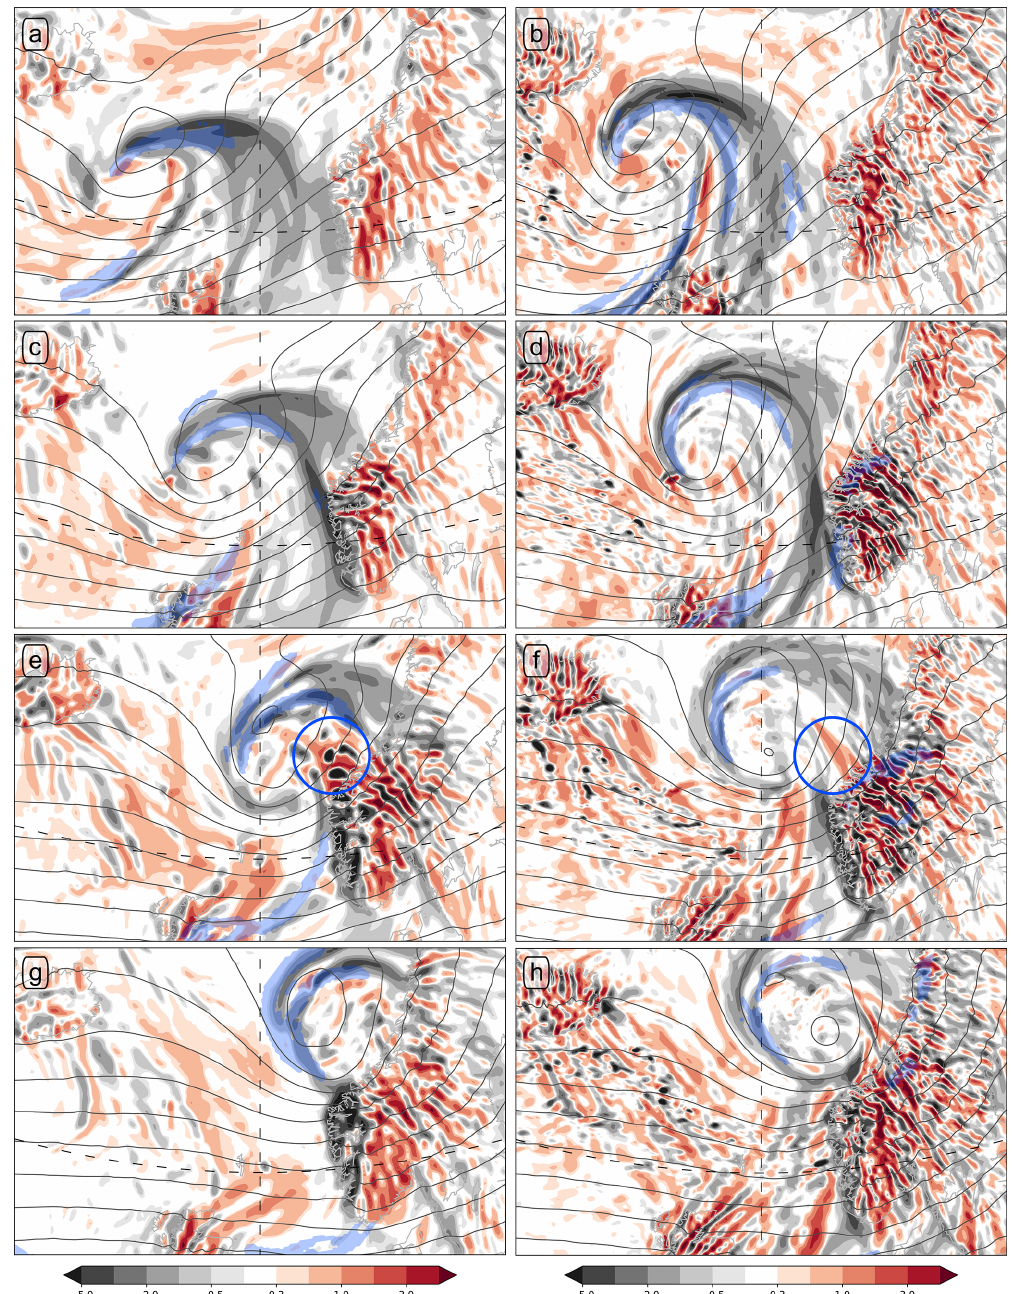
Figure 4. Pressure vertical velocity (Pas − 1 ) at 700hPa for (a, b) 00:00UTC, (c, d) 03:00UTC, (e, f) 06:00UTC, and (g, h) 09:00UTC. Dark grey contours show geopotential at 700hPa, with a contour interval of 50m, respectively. Blue shaded regions indicate the location of frontal zones at 850hPa for both columns. The left column is based on the NORA10 hindcasts and the right on the Control simulation. For the blue circles in (e, f) , refer to the main